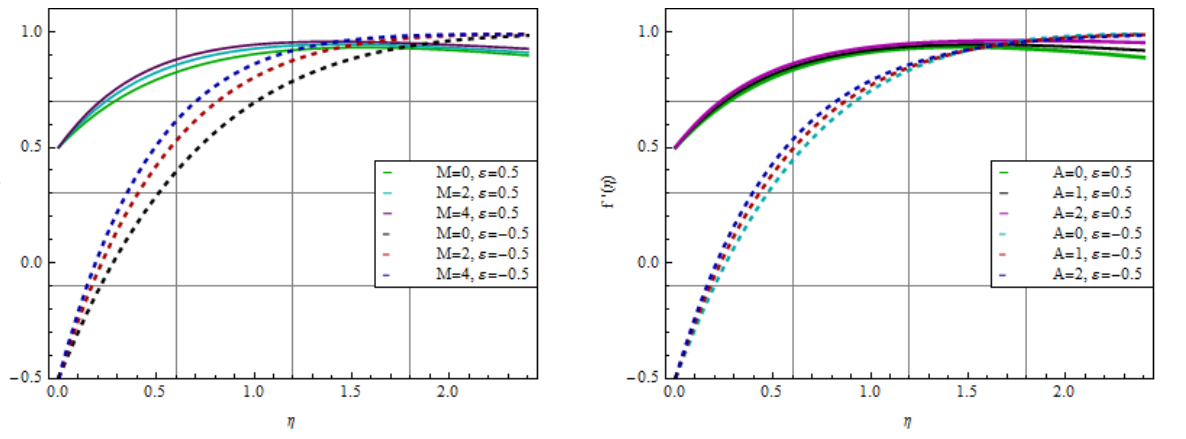
Table (5)-(7) present the values of skin friction coefficient and local Nusselt number with nanoparticle volume frac- tion ( ϕ ) in case of stretching/shrinking sheet and asssist- ing/opposing flows. Tables reveal that value of skin fric- tion coefficient and local Nusselt number are higher for Cu as nanoparticle compared to Al cles.